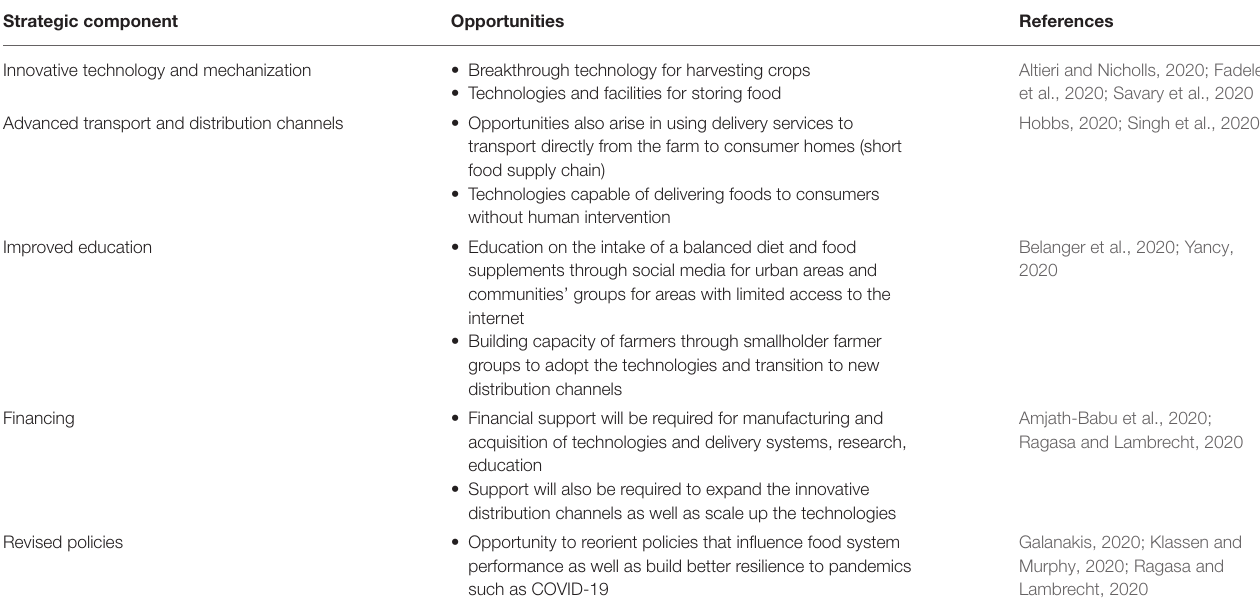
TABLE 9 | Innovative strategies to integrate into the current food